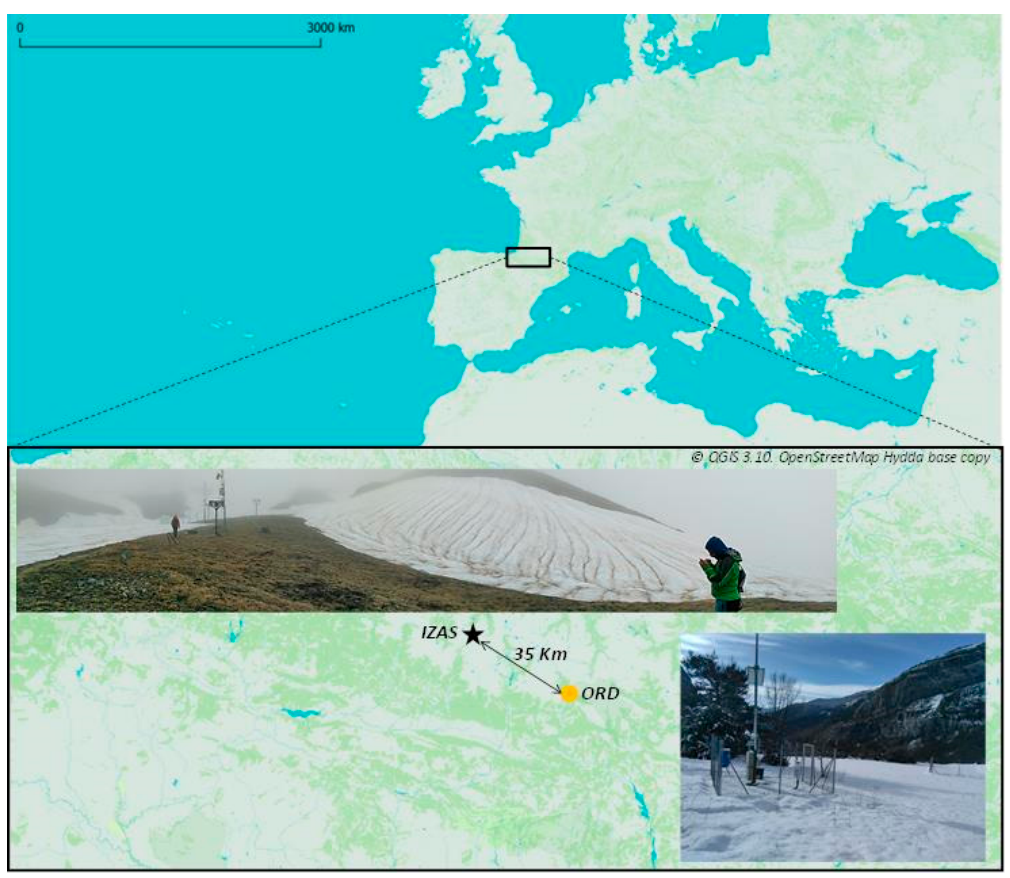
Figure 1. Location of the study area, situation of the monitoring sites (Izas and Ordesa and Monte Perdido National Park-ORD) and photos of the monitoring sites. Photos taken by J. Pey: Izas ( upper part ), on 29 May 2018; Ordesa ( bottom part ), on 9 January 2018.